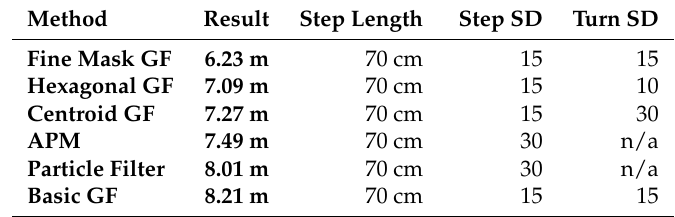
Table 4. The best overall result for every considered method on the IPIN 2019 validation